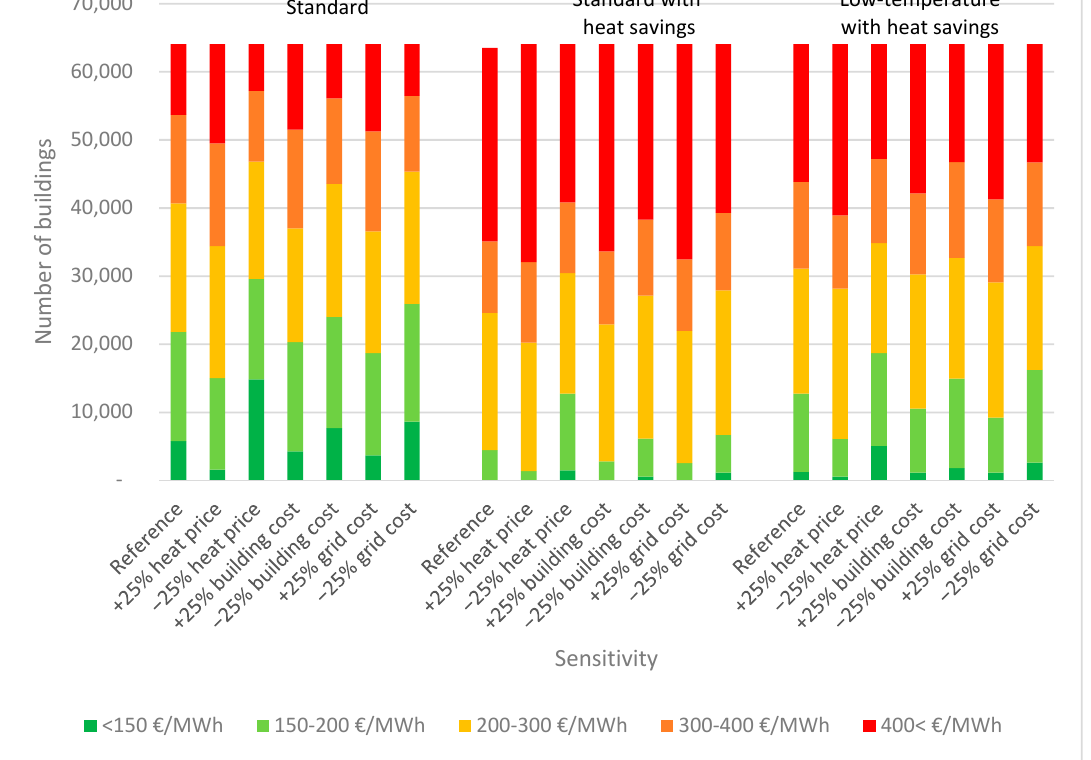
Figure 10. Sensitivity analysis of critical parameters.